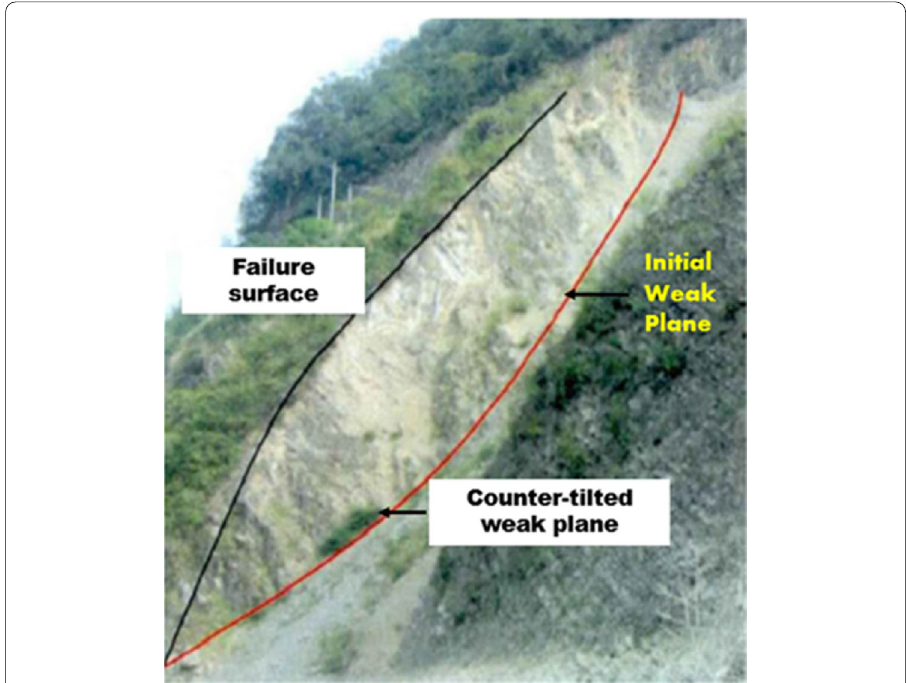
Fig. 1 Post-failure photograph of slide head toppling failure of the jointed rock slope in Zhongliang reservoir bank, China